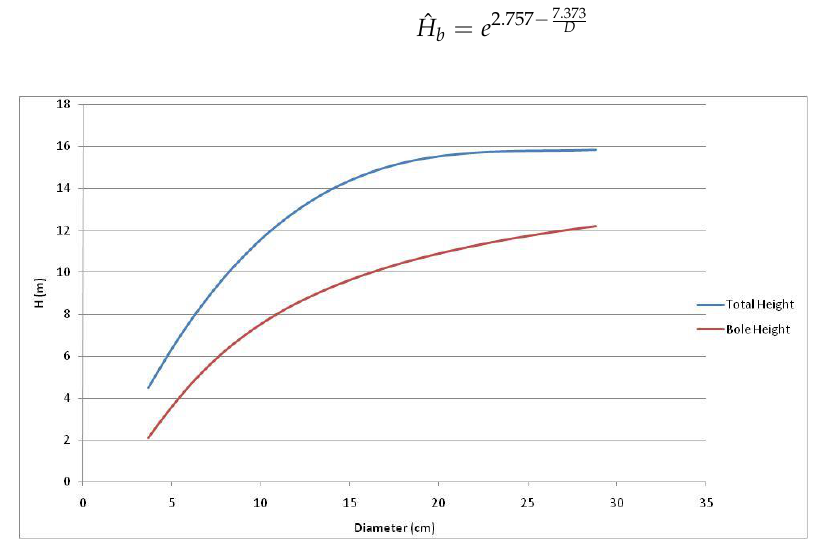
Figure 3. Height – diameter curves for Robiniapseudoacacia in the study area. Figure 3. Height–diameter curves for Robiniapseudoacacia in the study